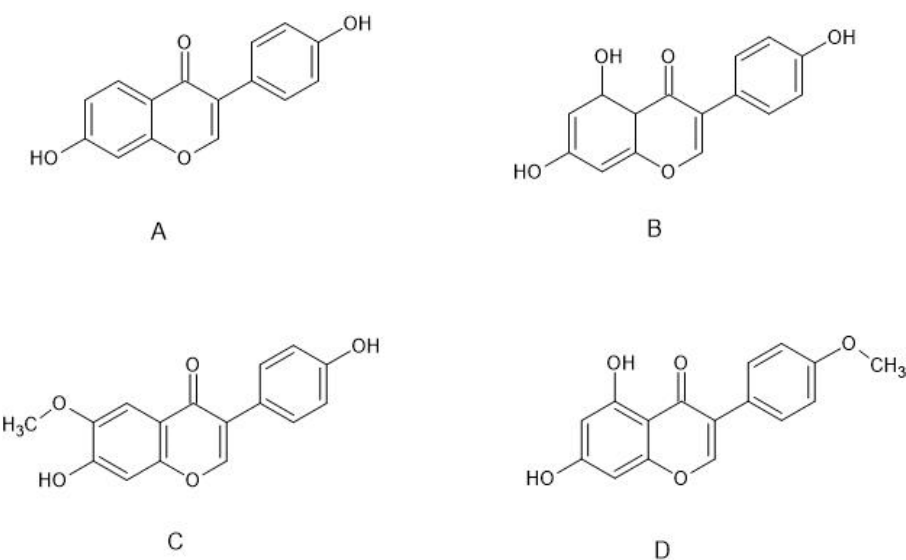
Figure 2. Structure of the main estrogenic isoflavones: ( A ) daidzein, ( B ) genistein, ( C ) glycitein, ( D ) biochanin A.